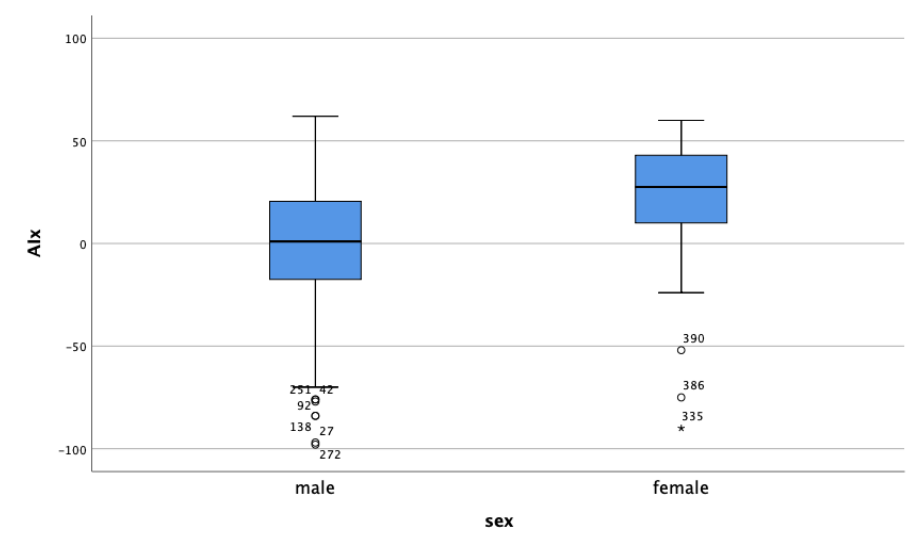
Figure 2. AIx according to sex.